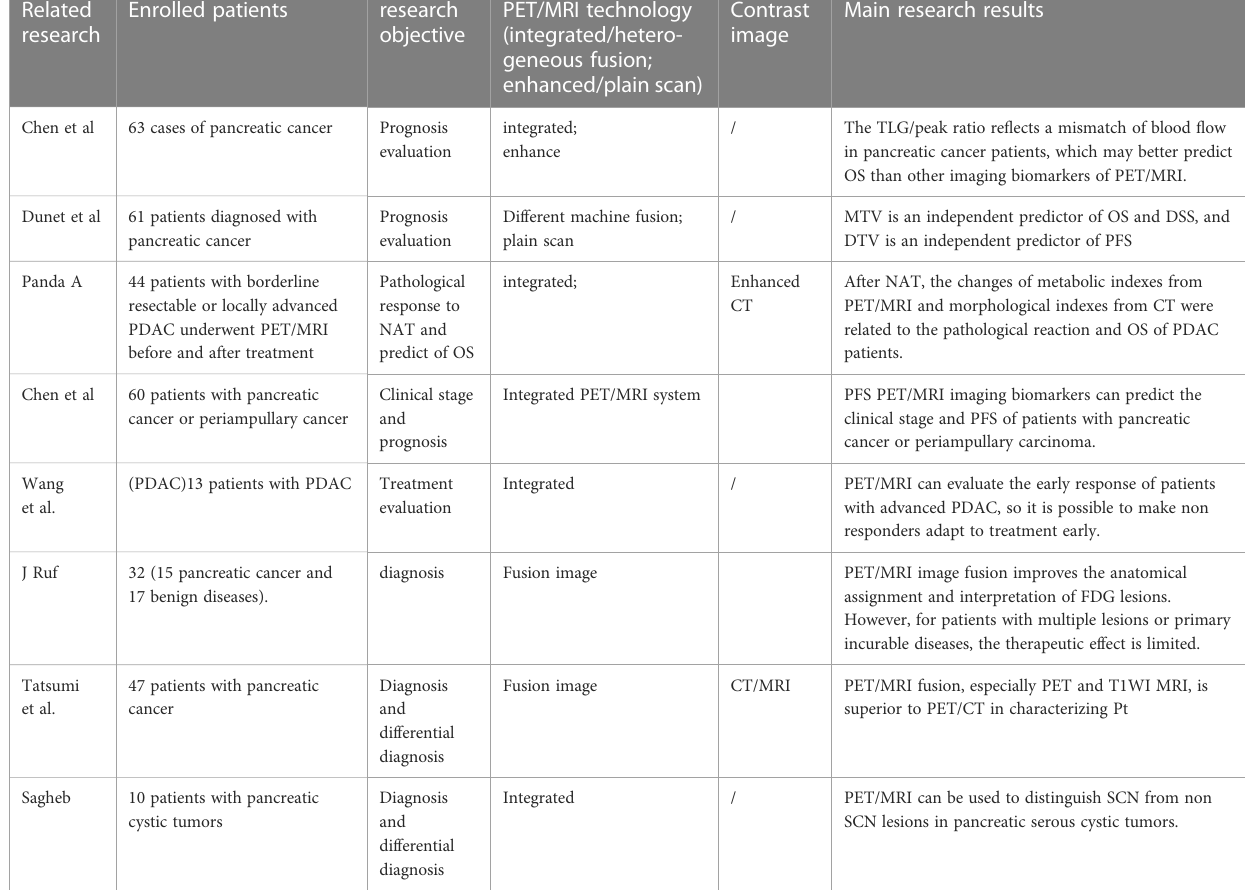
TABLE 1 Summary of studies related to the application of PET/MRII in pancreatic cancer.